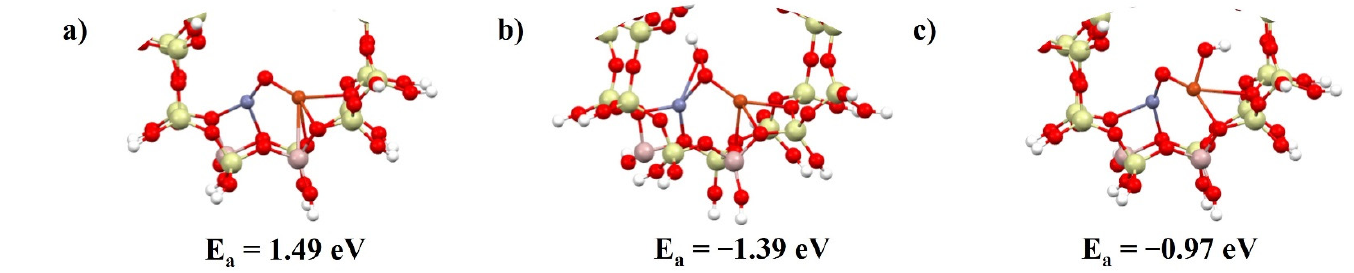
Figure 3. Cluster model of MFI zeolite structure with deposited bimetallic dimer ( a ) copper–zinc dimer, ( b ) copper–zinc dimer with hydroxyl group adsorbed on zinc, and ( c ) copper–zinc dimer with hydroxyl group adsorbed on copper, with adsorption energy below the structure.